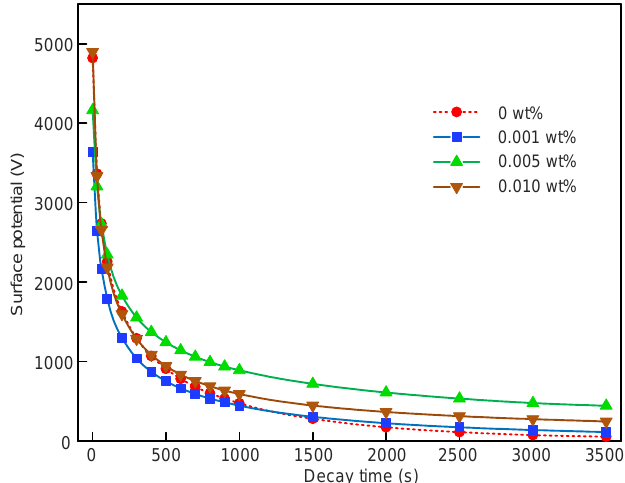
Figure 4. Surface potential decay in graphene/silicone rubber nanocomposites.